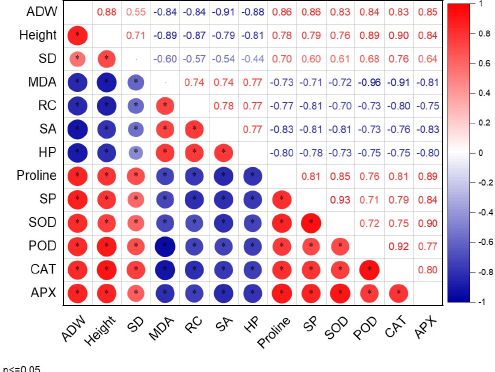
Figure 5. Correlation between aerial dry weight (ADW), height, stem diameter (SD), MDA, relative conductivity (RC), O 2 − (SA), H 2 O 2 (HP), proline, soluble protein (SP), SOD, POD, CAT, and APX of sorghum at maturity stage grown in saline soils. *: significant difference at p ≤ 0.05.